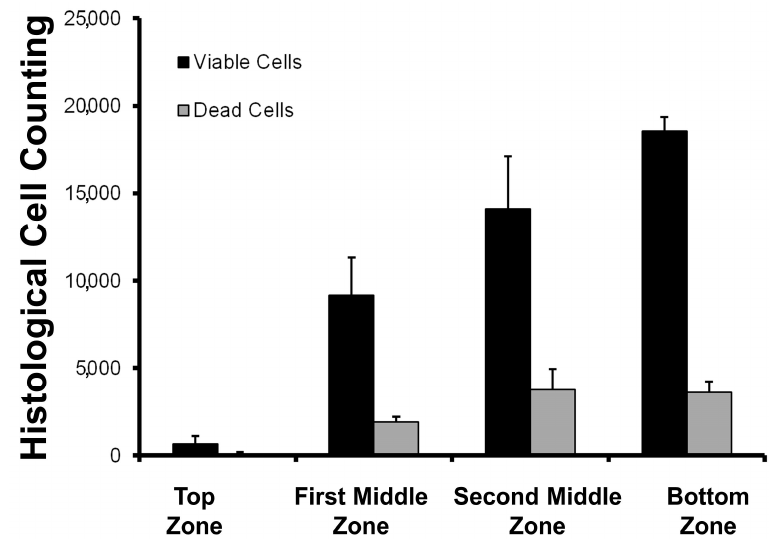
Figure 9. Cell distribution inside the scaffold (formula Bg) after 48 h of seeding. The scaffold thickness is 3 mm (each zone is close to 0.75 mm). The bottom zone is directly in contact with the cell culture plate.